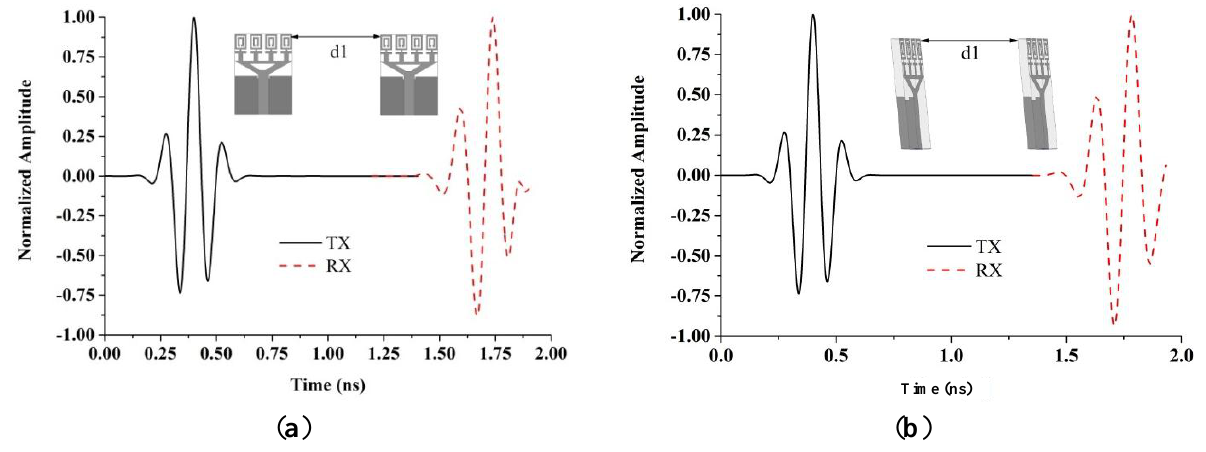
Figure 13. Transmitted and received pulses ( a ) side by side and ( b ) face to